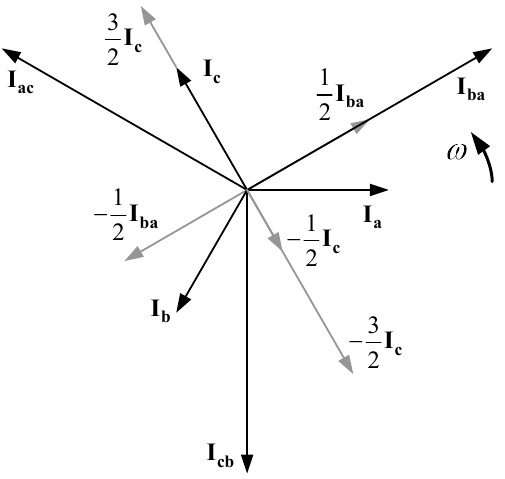
Figure 3. Electric current phasor representation in the I c - I ba reference system.